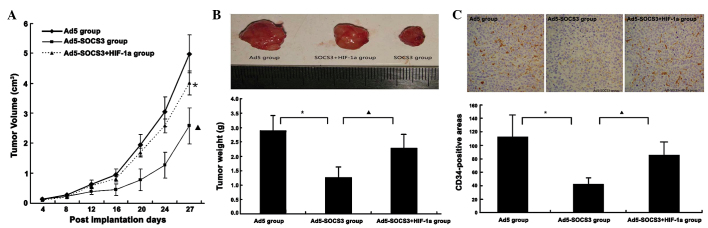
SOCS3 causes growth suppression and angiogenesis of NCI-H446 cells in vivo and HIF-1α is required in this process. (A) NCI-H446 cells were transfected with empty Ad5 vector, Ad5-SOCS3 or Ad5-SOCS3+HIF-1α. Subsequently, transfected cells (1×107) of the three groups were subcutaneously injected into mice to form transplantation tumors. The growth curve shows that compared with that of the Ad5 group, the growth rate of Ad5-SOCS3 cells was decreased, particularly from 21 days after inoculation (Ad5-SOCS3 group vs. Ad5 group, *P<0.05; n=11). Compared with that of the Ad5-SOCS3 group, the growth rate in the Ad5-SOCS3+HIF-1α co-transfection group was increased, particularly from 18 days after inoculation (Ad5-SOCS3+HIF-1α group vs. Ad5-SOCS3 group, ▲P<0.05, n=11). (B) Following sacrification of the mice 30 days after inoculation, tumor weight was significantly decreased in the Ad5-SOCS3 group (Ad5-SOCS3 group vs. Ad5 group, *P<0.05, n=11) as compared with that in the Ad5 group, but following co-transfection with HIF-1α, the tumor weight increased (Ad5-SOCS3+HIF-1α group vs. Ad5-SOCS3 group, ▲P<0.05, n=11). (C) Representative microscopic images of CD34 antibody-stained tumor sections (magnification, ×10). The bar graph shows the mean neovascular densities ± standard deviation. Images of the entire area of each tumor were captured and analyzed. Results of immunohistochemical semiquantitative analysis showed that the number of CD34-positive areas was decreased following transfection with SOCS3 as compared with that in the empty vector-transfected group (*P<0.05), while this effect was significantly reduced following co-transfection with HIF-1α (Ad5-SOCS3+HIF-1α group vs. Ad5-SOCS3 group, ▲P<0.05). Ad5, tumor-specific replication-defective adenovirus type 5; SOCS3, suppressor of cytokine signaling, 3; HIF-1α, hypoxia-inducible factor-1α.